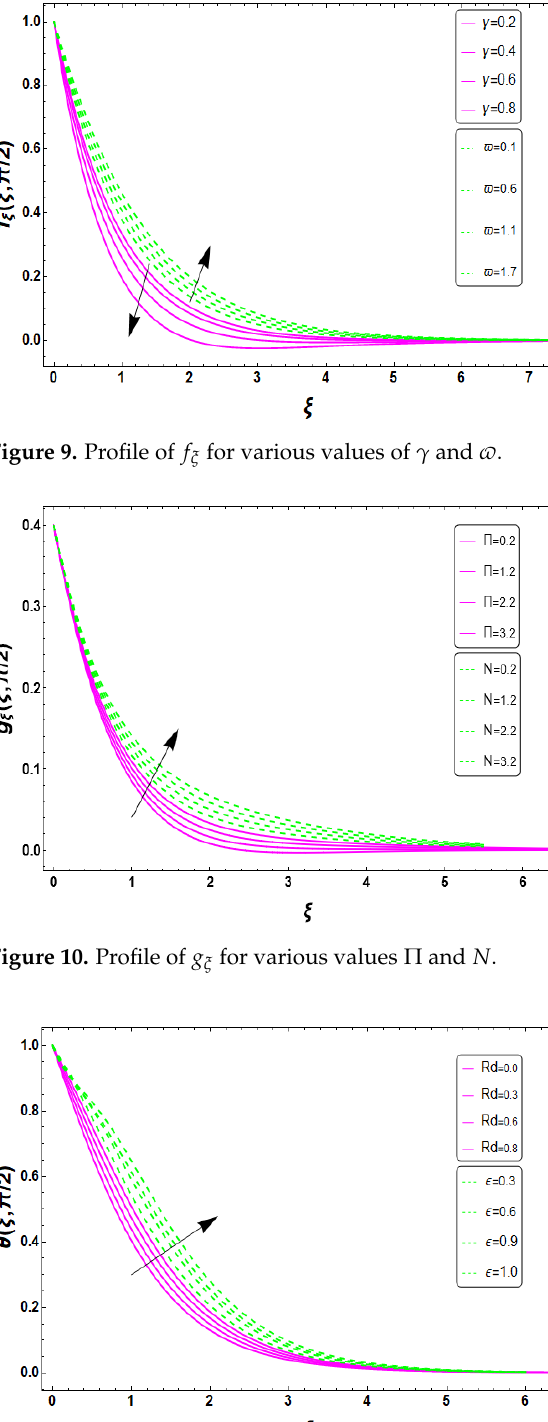
Figure 8. ( a ) E ff ects of